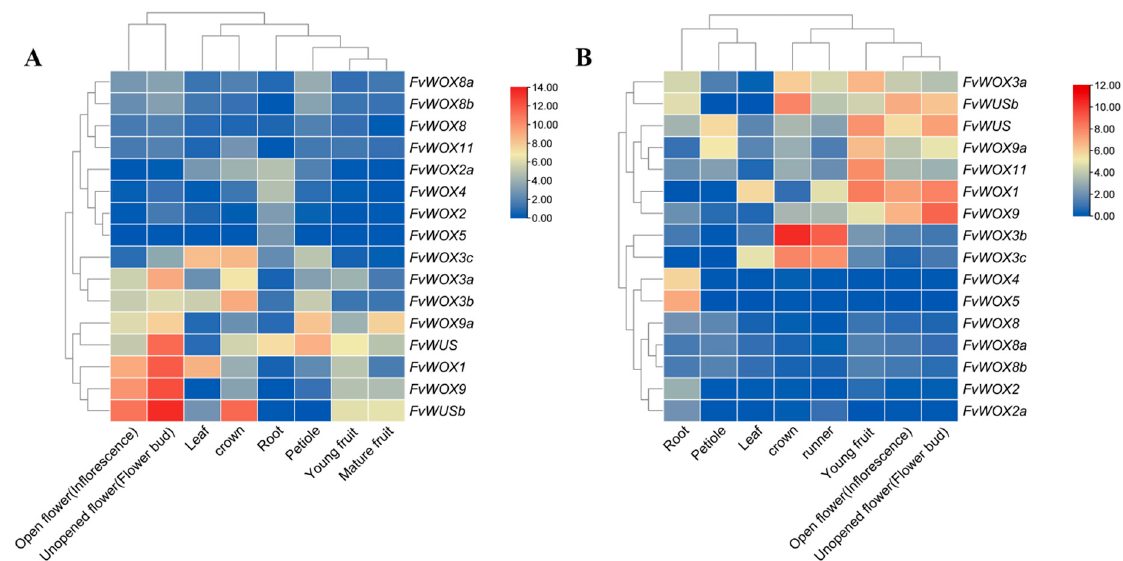
Figure 5. Tissue-specific expression of FvWOXs in two woodland strawberry varieties, Ruegen ( A ) and Hawaii 4 ( B ). The color scale represents gene expression levels. Blue indicates low expression level, red indicates high expression level. Clustering based on log2-transformed FPKM values of 16 FvWOX genes that are detected in at least one tissue based on the FPKM 95% confidence interval lower boundary greater than zero.